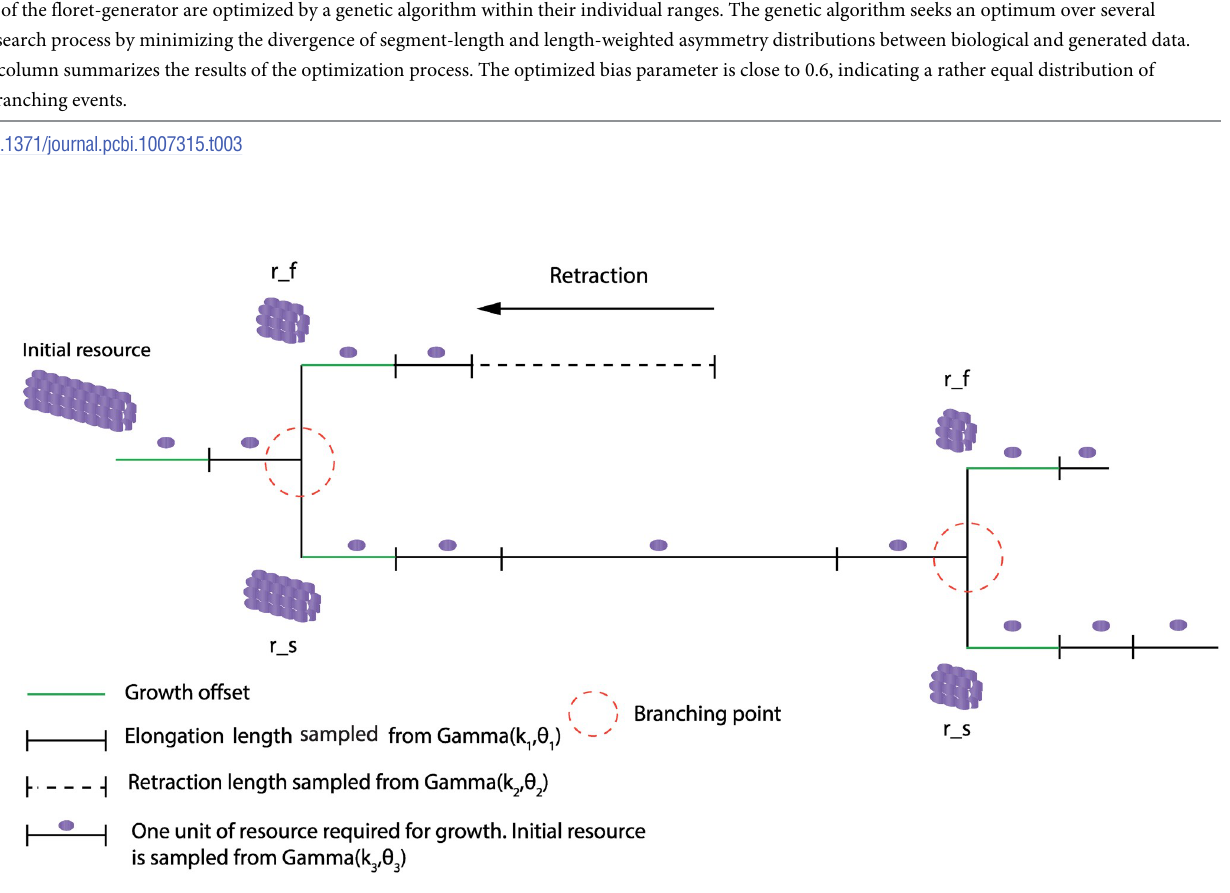
Fig 5. Components of the floret-generator algorithm. The floret-generator allows for growth, branching or retraction. Growth and retraction lengths are both sampled from respective gamma distributions. When a growth event occurs, an initial offset length is formed first. An initial resource budget is sampled from a Gamma distribution, and resource is reduced by one unit after each growth step. After branching, a bias parameter decides on the distribution of resource to the daughter segments. The parameters of the gamma distributions as well as all other parameters of the model are optimized by a genetic